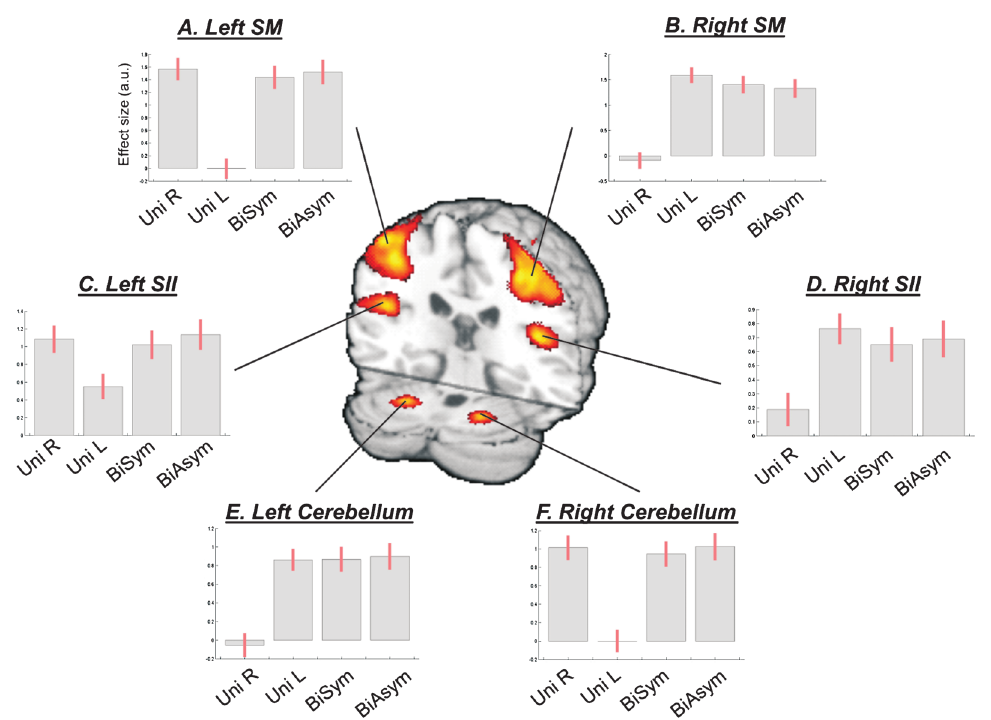
Figure 2. Network of brain areas activated during passive movement. Passive movement activated sensory-motor (SM) regions around the central sulcus contralateral to the stimulated hand, secondary somatosensory areas (SII) in the parietal operculum, and ipsilateral cerebellum. The SMA also activated for all four movement conditions (not shown, see Table 1 ). The signal plots display the level of activation for each movement condition compared with Rest. Effect sizes are in arbitrary units (a.u.), (cid:2) 90% confidence